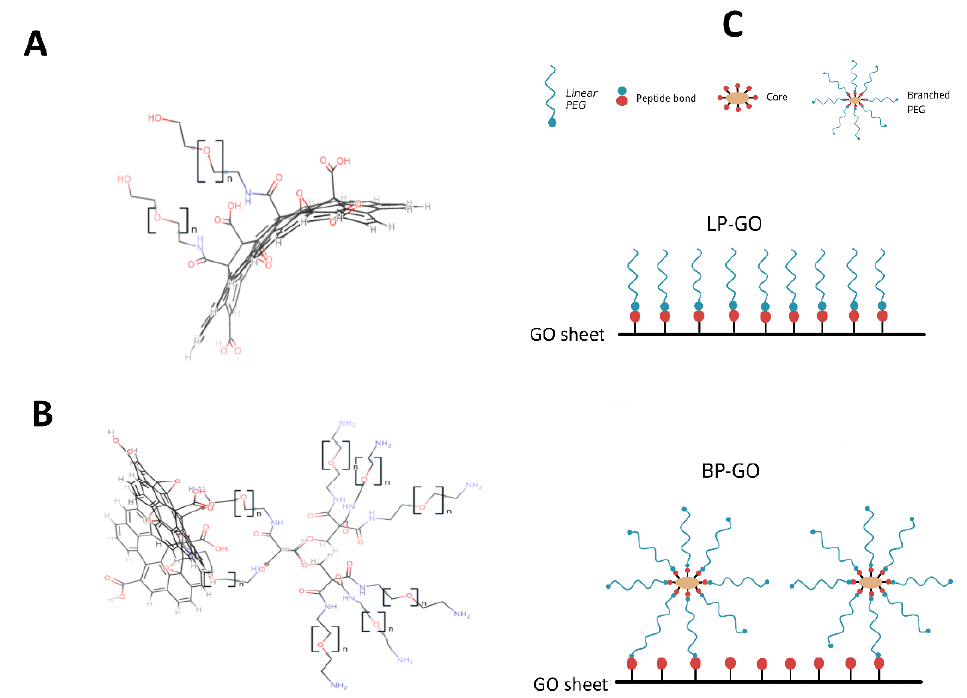
Figure 2. Structural formulas and a schematic representation of the surface of pegylated GO nanoparticles. ( A ) structural formula of LP-GO nanosheet, ( B ) structural formula of BP-GO nanosheet, ( C ) a schematic representation of both types of nanoparticles. Note: the ratio of the sizes of PEG and GO is not met.